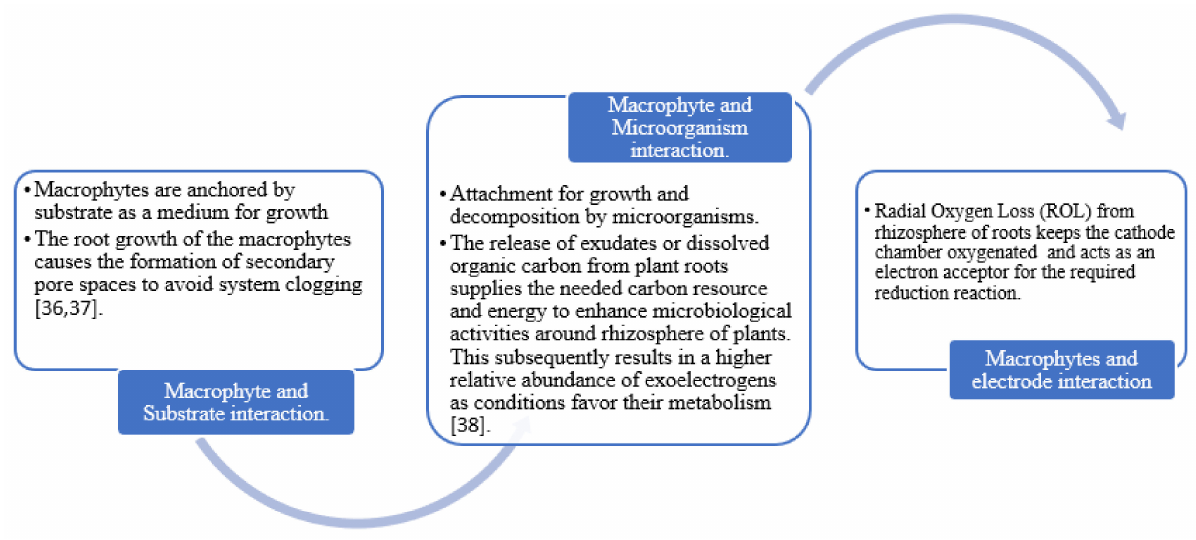
Figure 2. Interaction between macrophytes and other physical components of